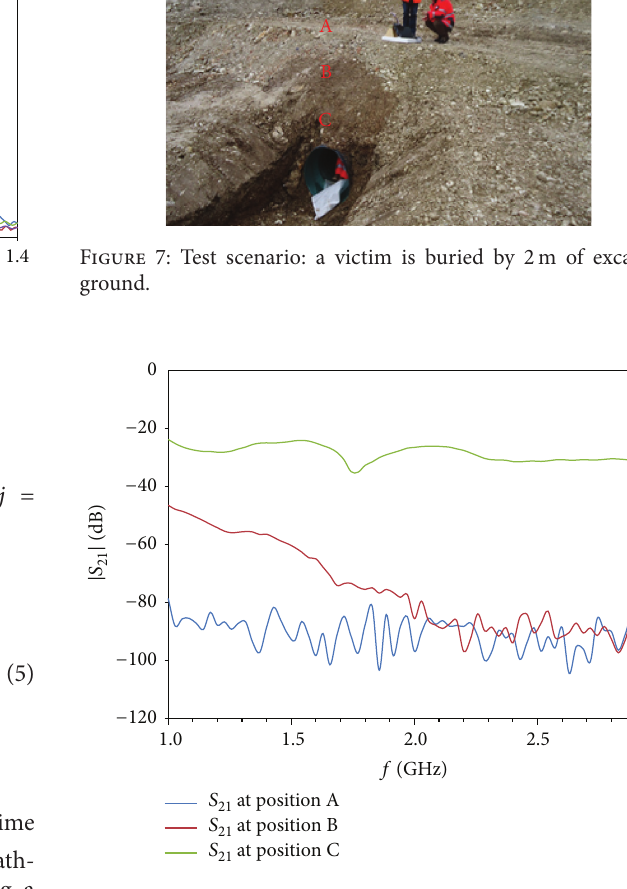
Figure 8: |𝑆 21 | measurement when the transmitting antenna is placed at positions A, B, and